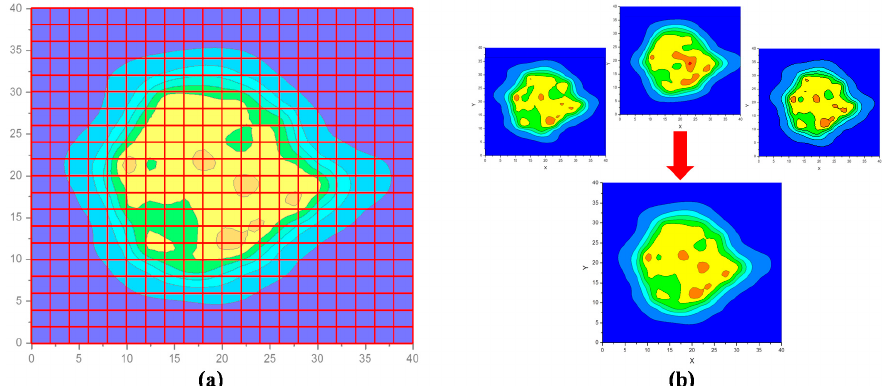
Figure 5. Wall film distribution obtained methods for dry wall conditions: ( a ) the distribution of the measurement points (21 × 21); ( b ) the average distribution of the wall film taken methods.